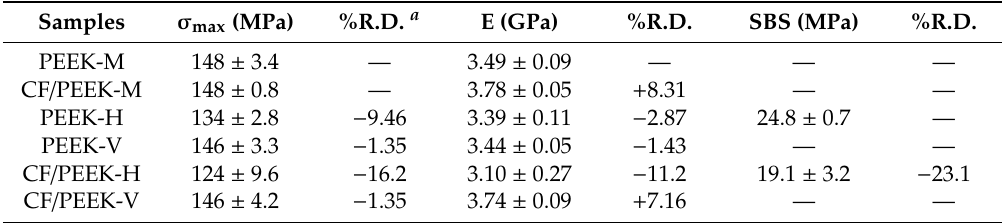
Table 2. Main bending properties of PEEK and CF / PEEK printed